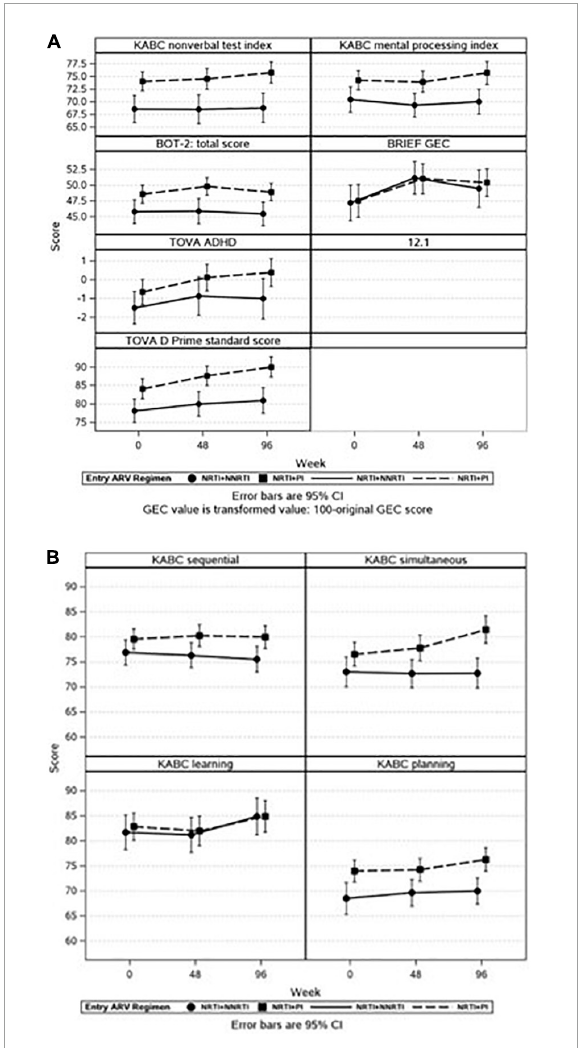
FIGURE3 (A,B) It illustrates adjusted means with 95% confidence intervals (CI) for selected neuropsychological outcomes across time by entry ARV regimen. There was increased risk for lower neuropsychological scores in all domains except for the BRIEF GEC if a child was receiving NRTI + NNRTI rather than NNRTI + PI at P1104s start. Each panel represents a different outcome. (A) Represents the full battery of neuropsychological tests, (B) represents the KABC